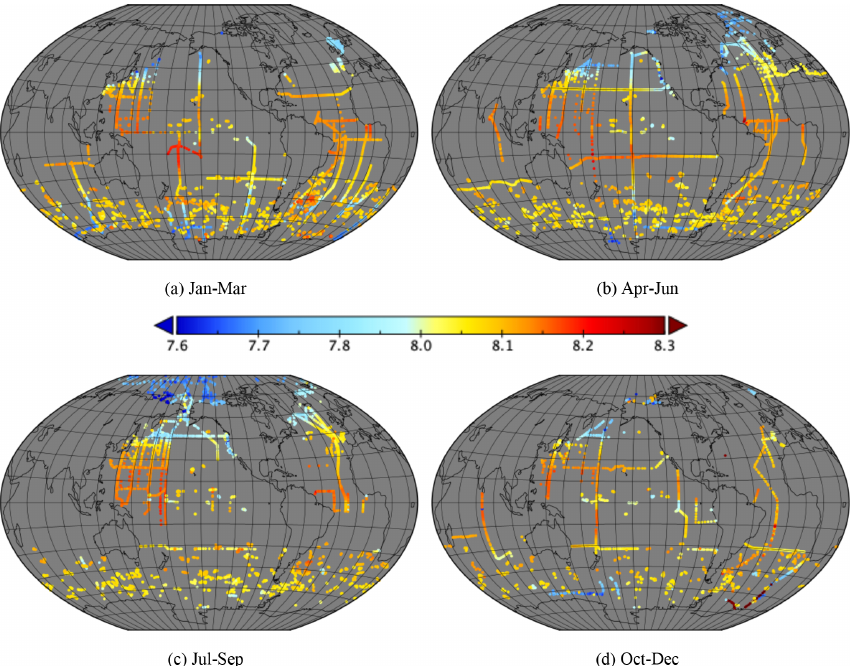
Figure 10. Mean pH (total scale, p = 0, 25 ◦ C) divided into seasons. (a) January–March (5501 ROIs), (b) April–June (5386 ROIs), (c) July– September (4959 ROIs) and (d) October–December (3767 ROIs).